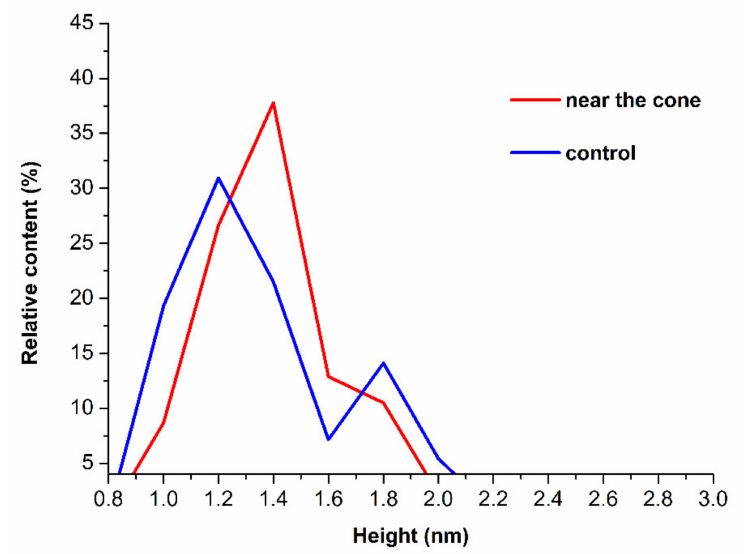
Figure 3. Relative height distributions of objects visualized by AFM on mica substrates incubated near the top of the cone with the power supply turned on (red curve) or off (blue curve).